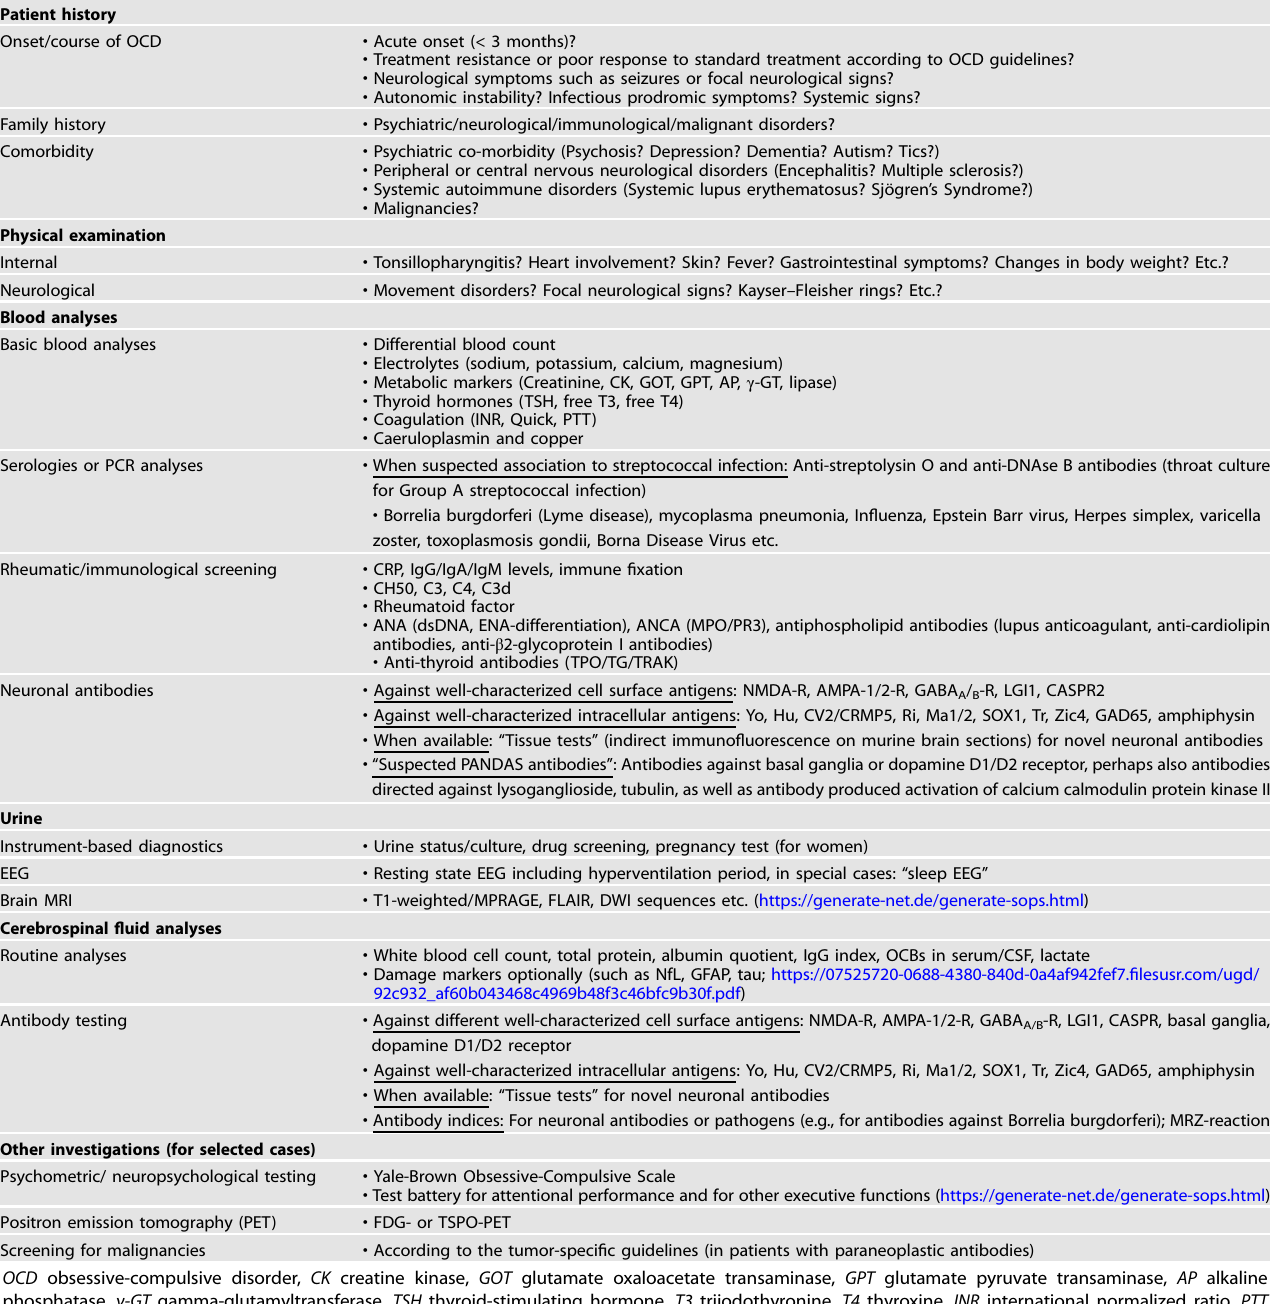
Table 3. Diagnostic investigations for the detection of autoimmune causes of obsessive-compulsive disorders and other psychiatric syndromes (compare with [34, 108,